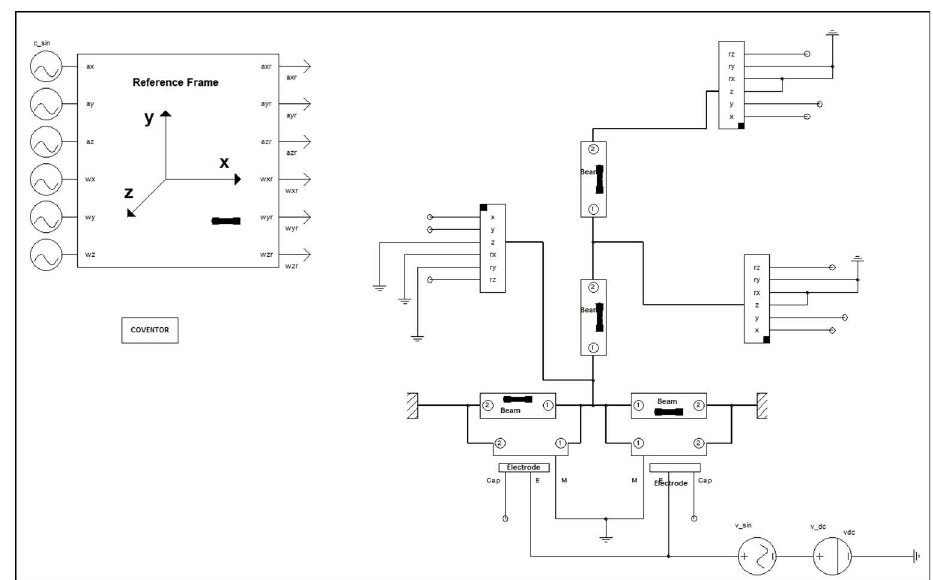
Figure 6. System schematic in CoventorWare© Architect.